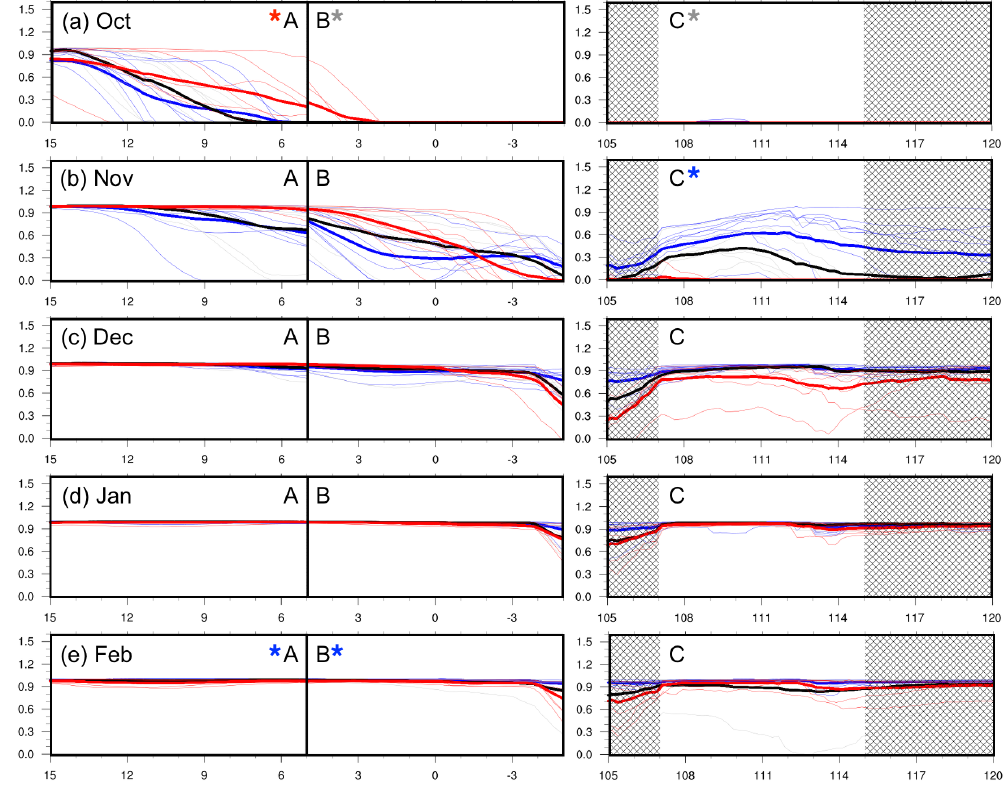
Figure 8. Like Fig. 6 but for the “sign” component, which reflects monsoon wind